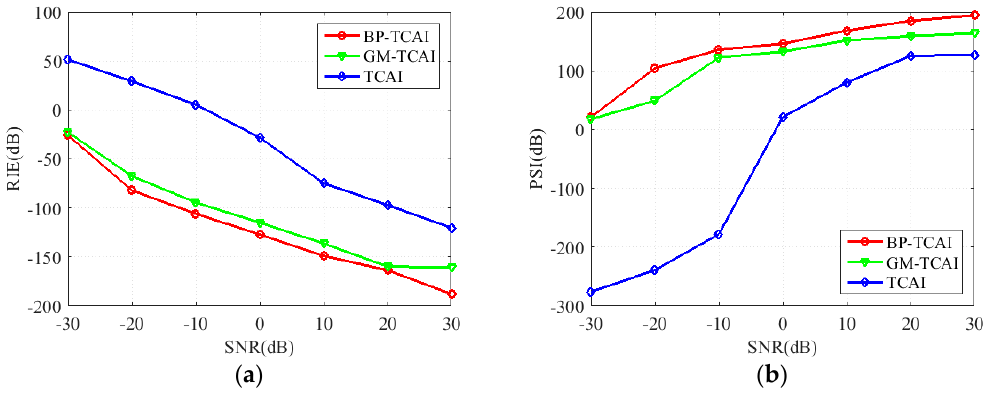
Figure 9. ( a ) RIE comparisons of TCAI, GM ‐ TCAI and BP ‐ TCAI, ( b ) PSI comparisons of TCAI, GM ‐ TCAI and BP ‐ TCAI.